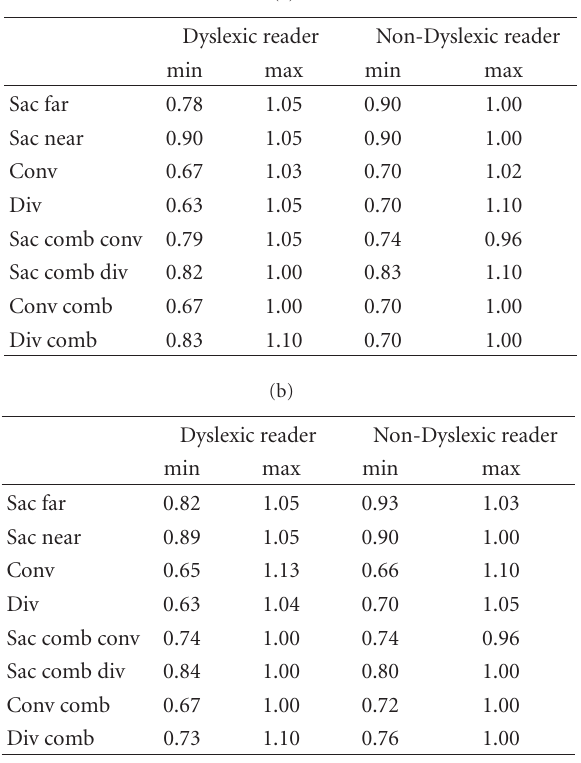
Table 3: Minimum and maximum gain values for dyslexic and non- dyslexic reader children measured for each type of eye movements examined in the gap (a) and in the simultaneous (b)